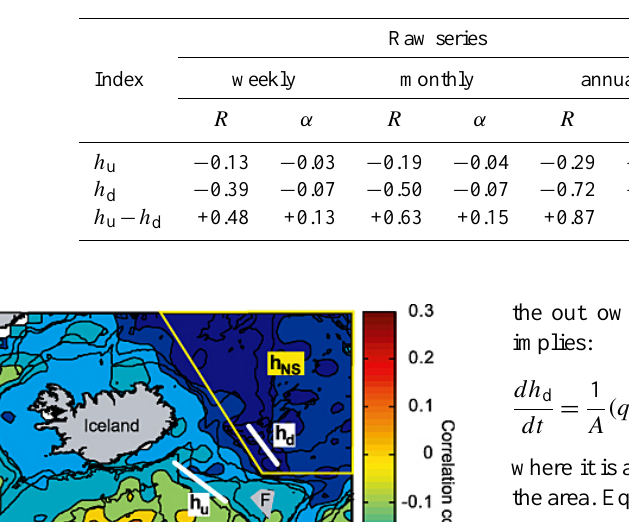
Table 1. Correlation coefficients ( R ) and proportionality factor α in Eq. (2) (in Svcm − 1 ) between IF-inflow and various indices for SLH based on weekly, monthly (four weeks), and annually averaged values. The last two columns (modified series, Sect. 2.2) show correlation co- efficients between “pre-whitened” (von Storch and Zwiers, 1999), de-seasoned, high-pass filtered, weekly averaged series and their statistical significance.